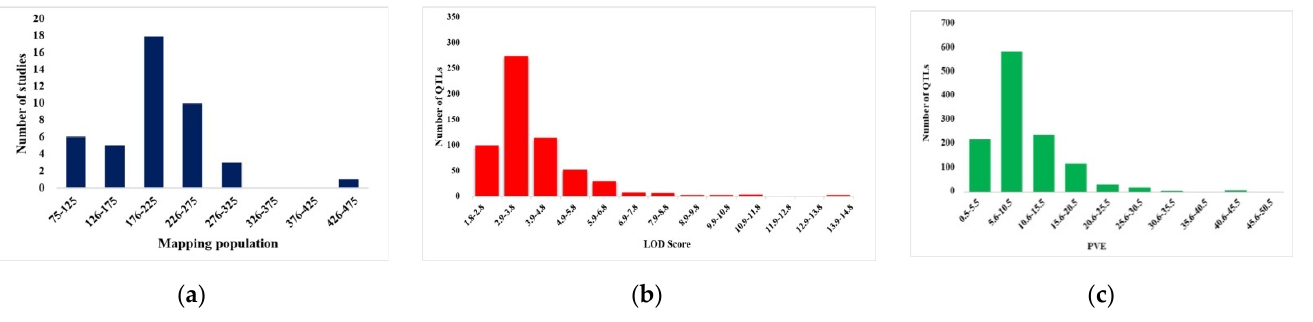
Figure 2 . Frequency distribution of ( a ) population size used in the individual studies (blue bar chart); ( b ) LOD score of initial QTLs (red bar chart); ( c ) PVE (%) of initial QTLs (green bar chart) from the previous studies.